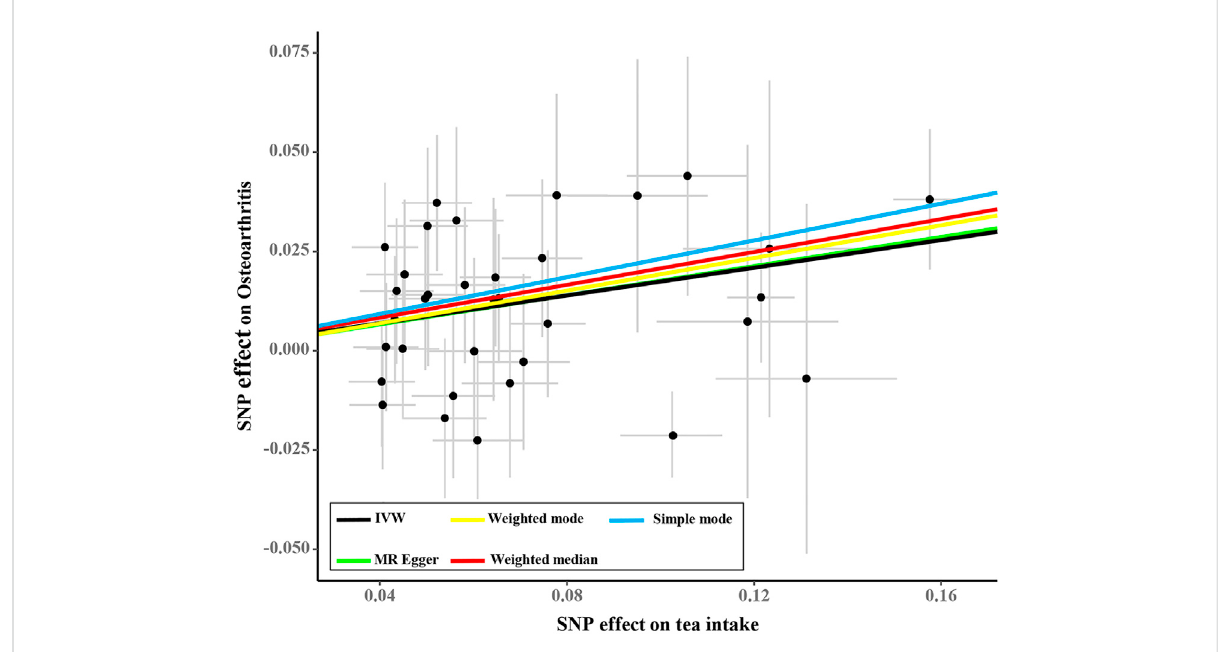
FIGURE 2 Scatter plot of the effect size for each SNP on tea consumption and